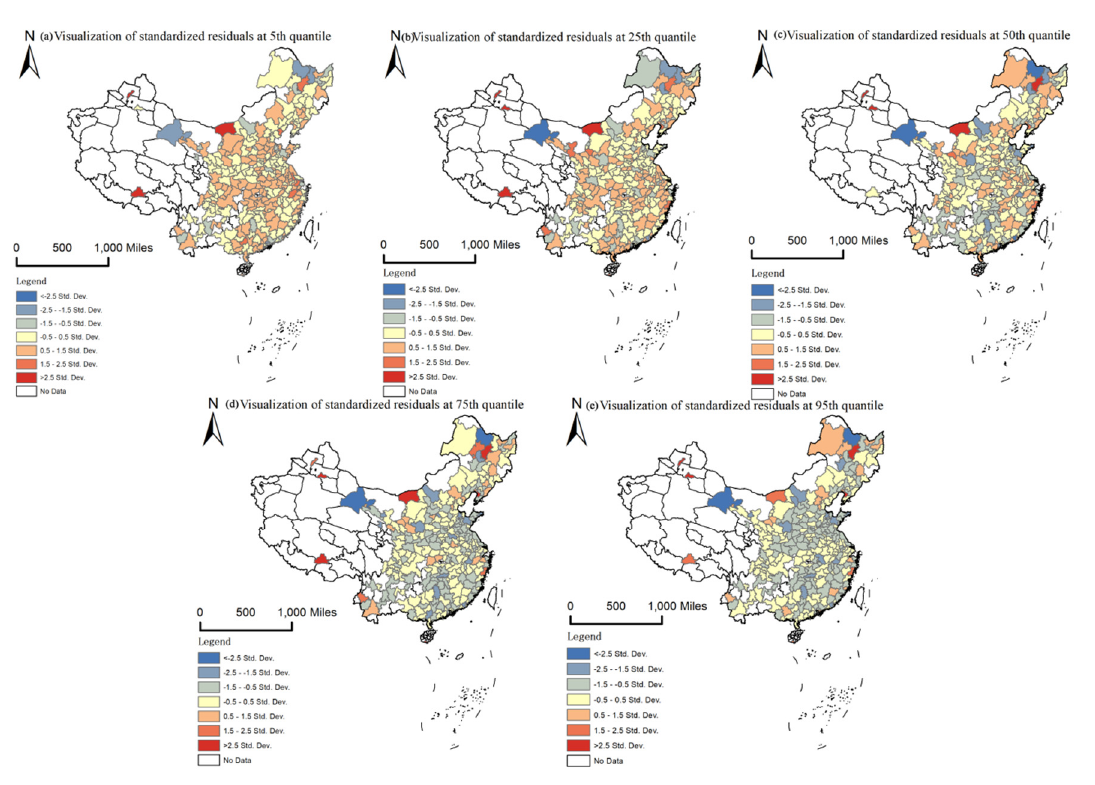
Figure 5. Spatial visualization of standardized residuals of GWQR for 2013. ( a – e ) represent the spatial distribution of standardized residuals for the 5th, 25th, 50th, 75th, and 95th quantiles respectively.